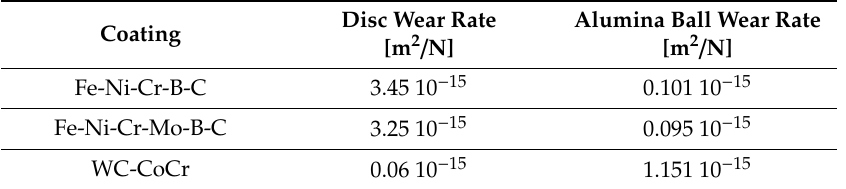
Table 7. Wear rates after ball-on-disc tests